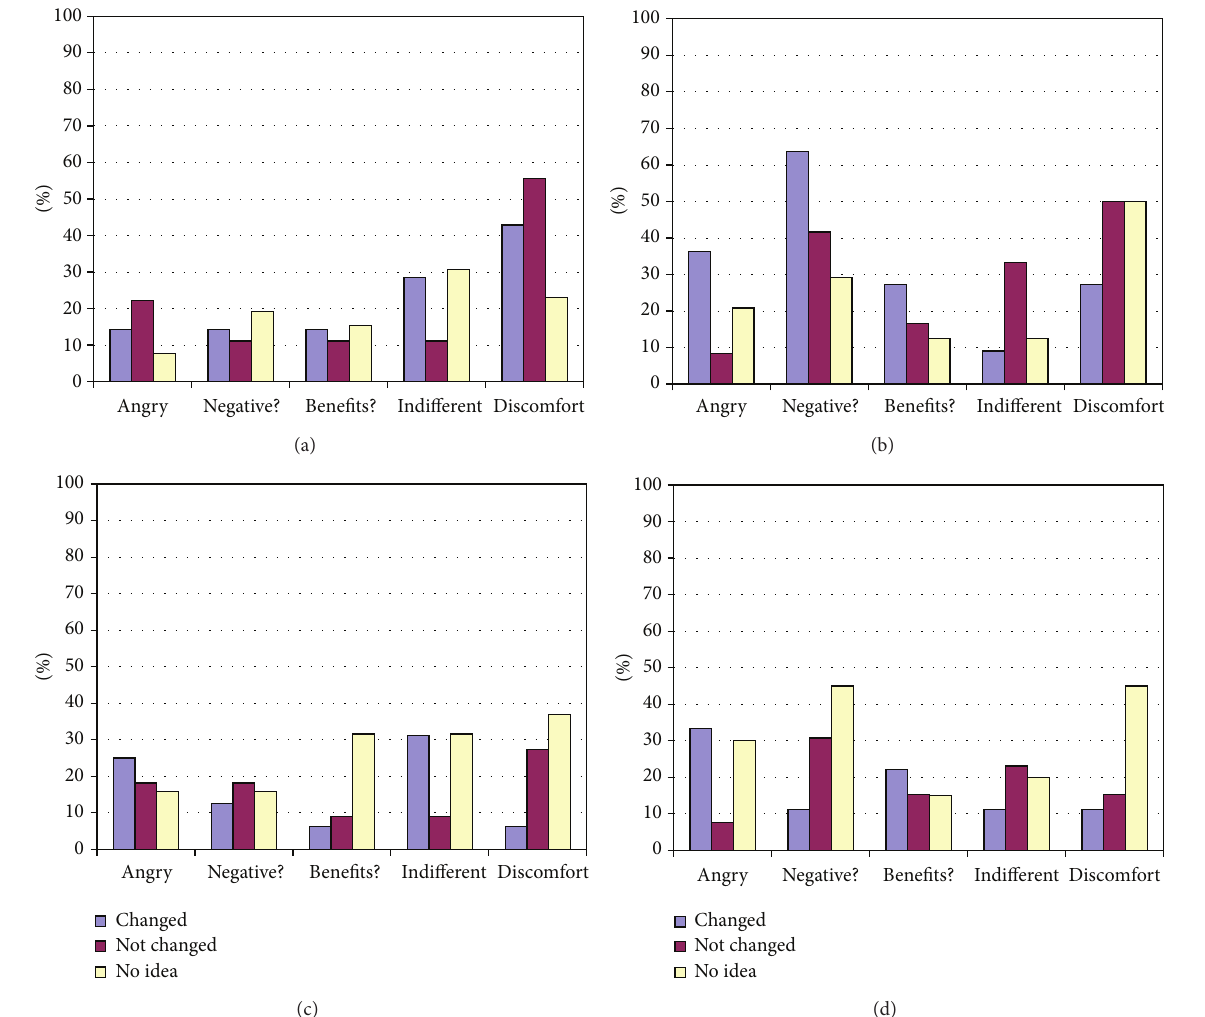
Figure 17: Reaction to be contacted according to privacy settings changes: (a) DN men; (b) DN women; (c) DI men; (d) DI